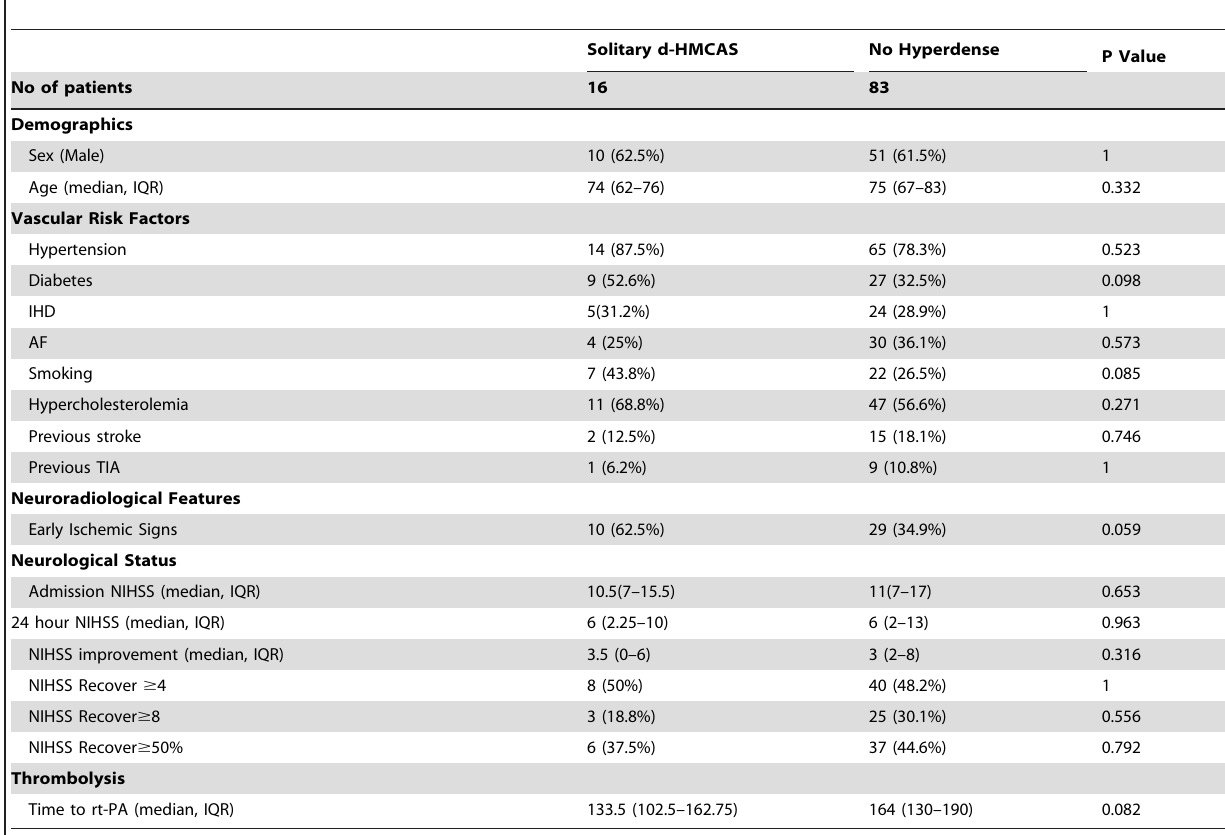
Table 3. Baseline data and response to rt-PA between patients with d-HMCAS and patients without any hyperdense